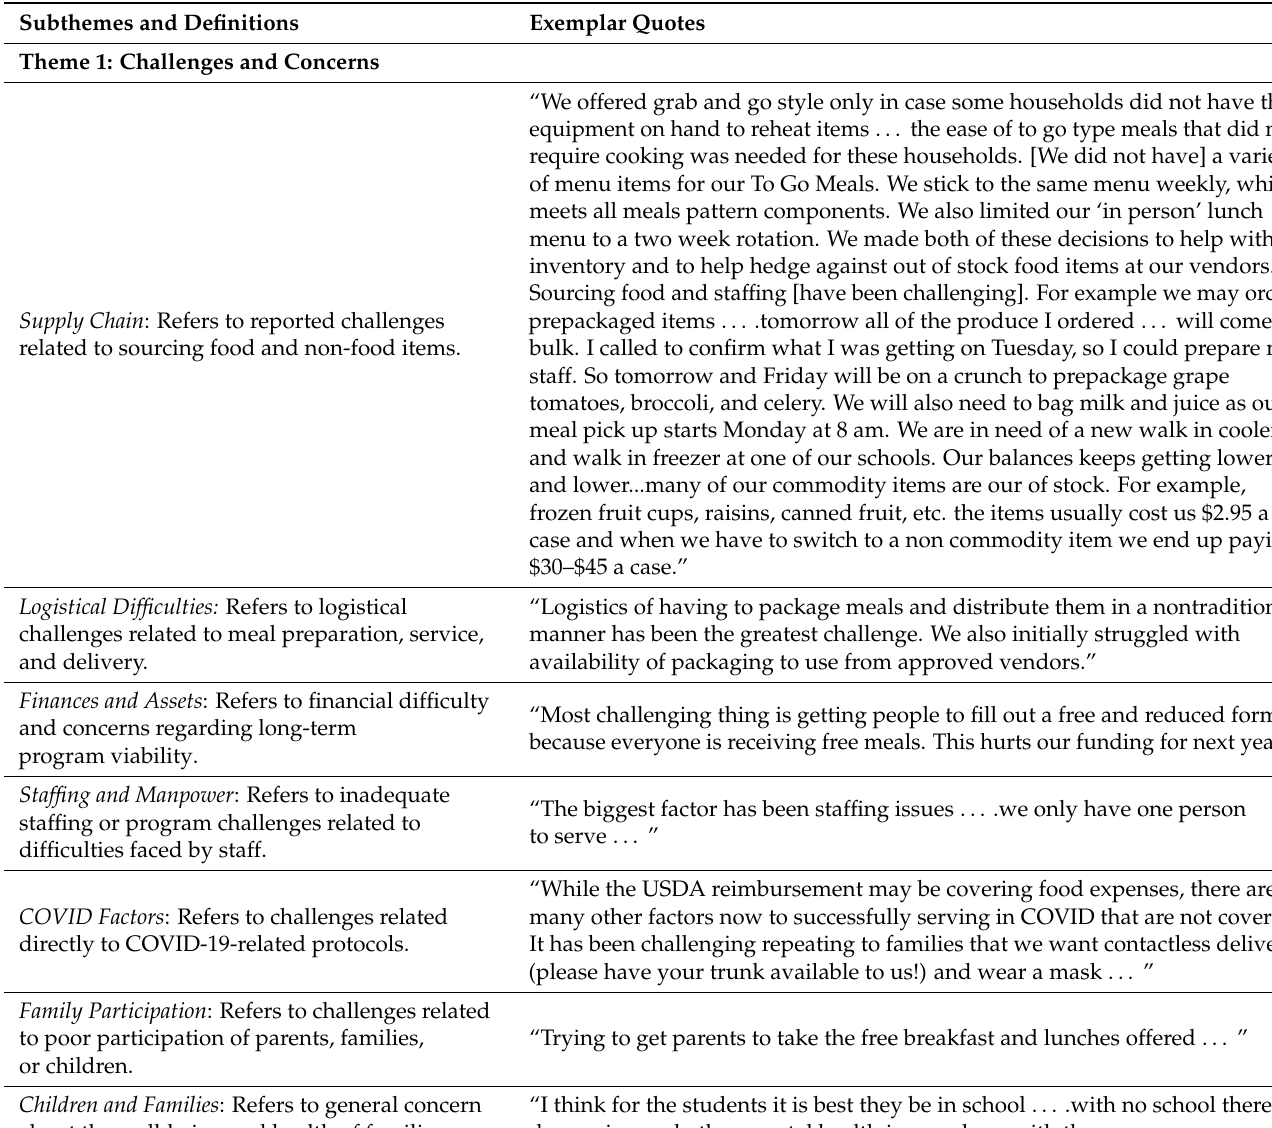
Table 4. Summary of Qualitative Data Themes and